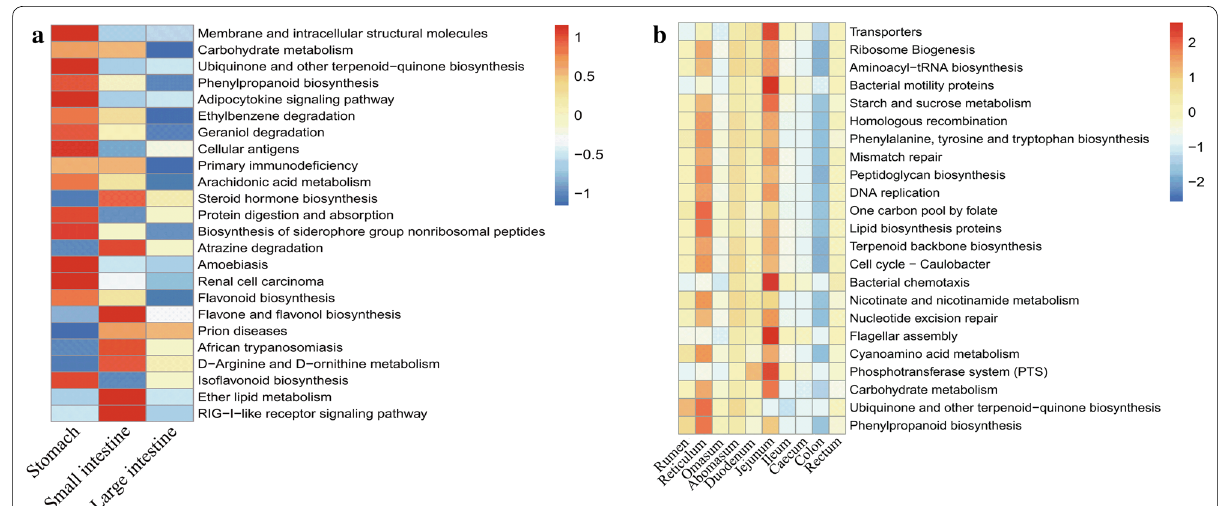
Fig. 5 Predicted function of the gut micorbiota in the sheep of GIT. KEGG pathways were shown in two heatmaps. The bootstrap Mann–Whit- ney u-test was used to detect the gene distribution with cutoffs of P < 0.05, FDR <0.2, Mean counts >10,000 ( a ) and P < 0.01, FDR <0.1, Mean counts >10 ( b